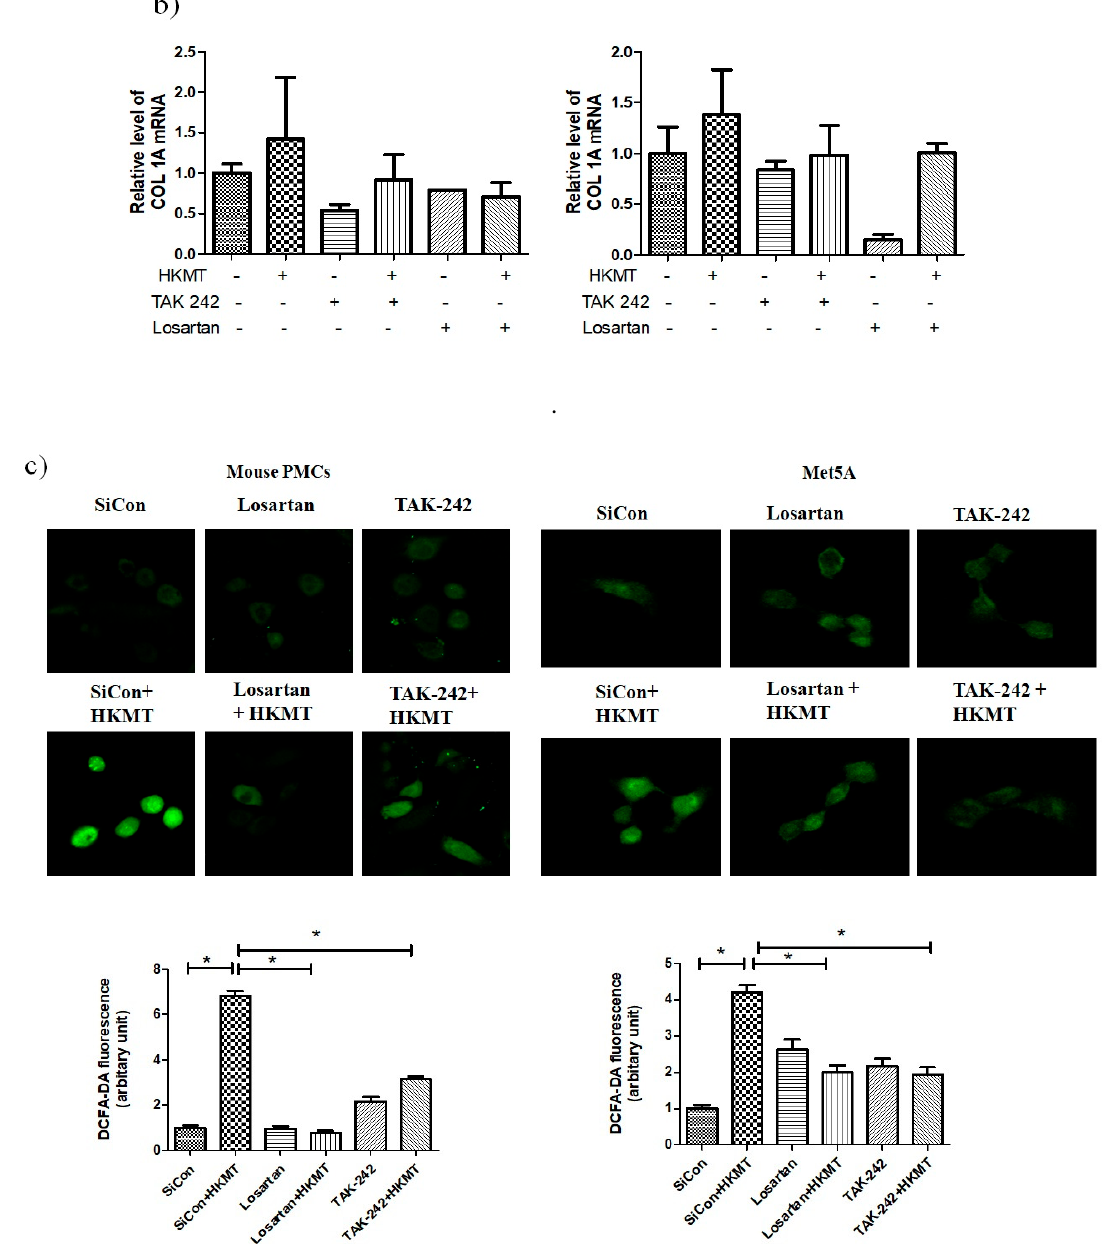
Figure 4. Toll like receptor 4 (TLR4) inhibition and angiotensin II receptor type1 (AT1R)